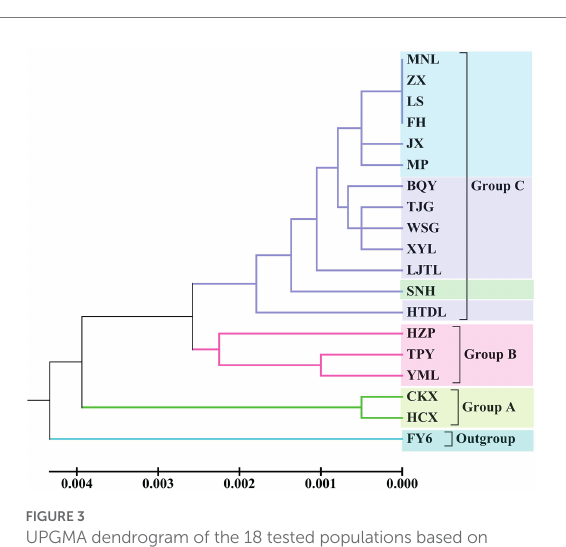
FIGURE 2 UPGMA dendrogram of the 18 tested populations based on ISSR and SRAP markers.